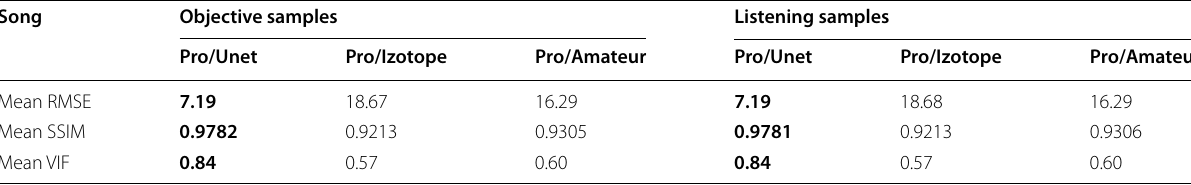
Table 6 Comparison of means for all